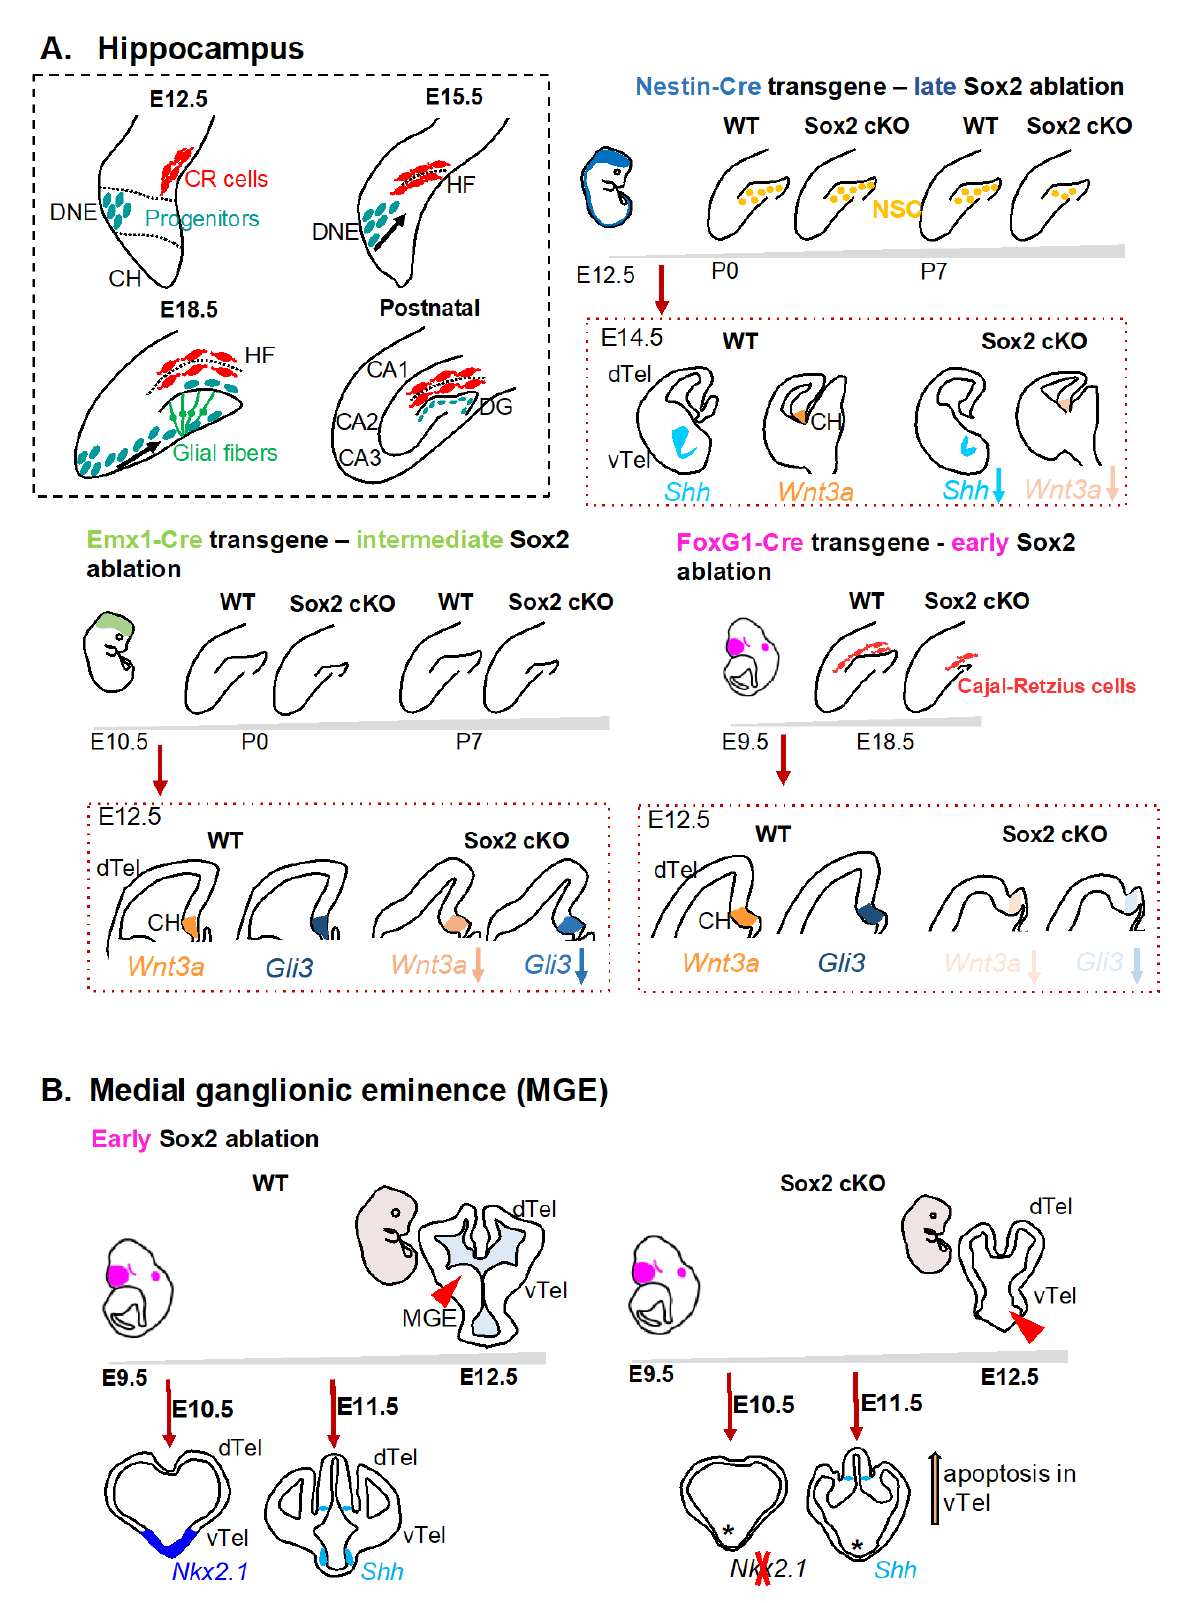
Figure 1. Schematic representation of defects arising from Sox2 deletion in the telencephalon of Sox2 cKO mice. ( A ). Hippocampus. Top left, schematic representation illustrating hippocampus development. Progenitor cells initially localized to the dentate neuroepithelium (DNE) migrate towards